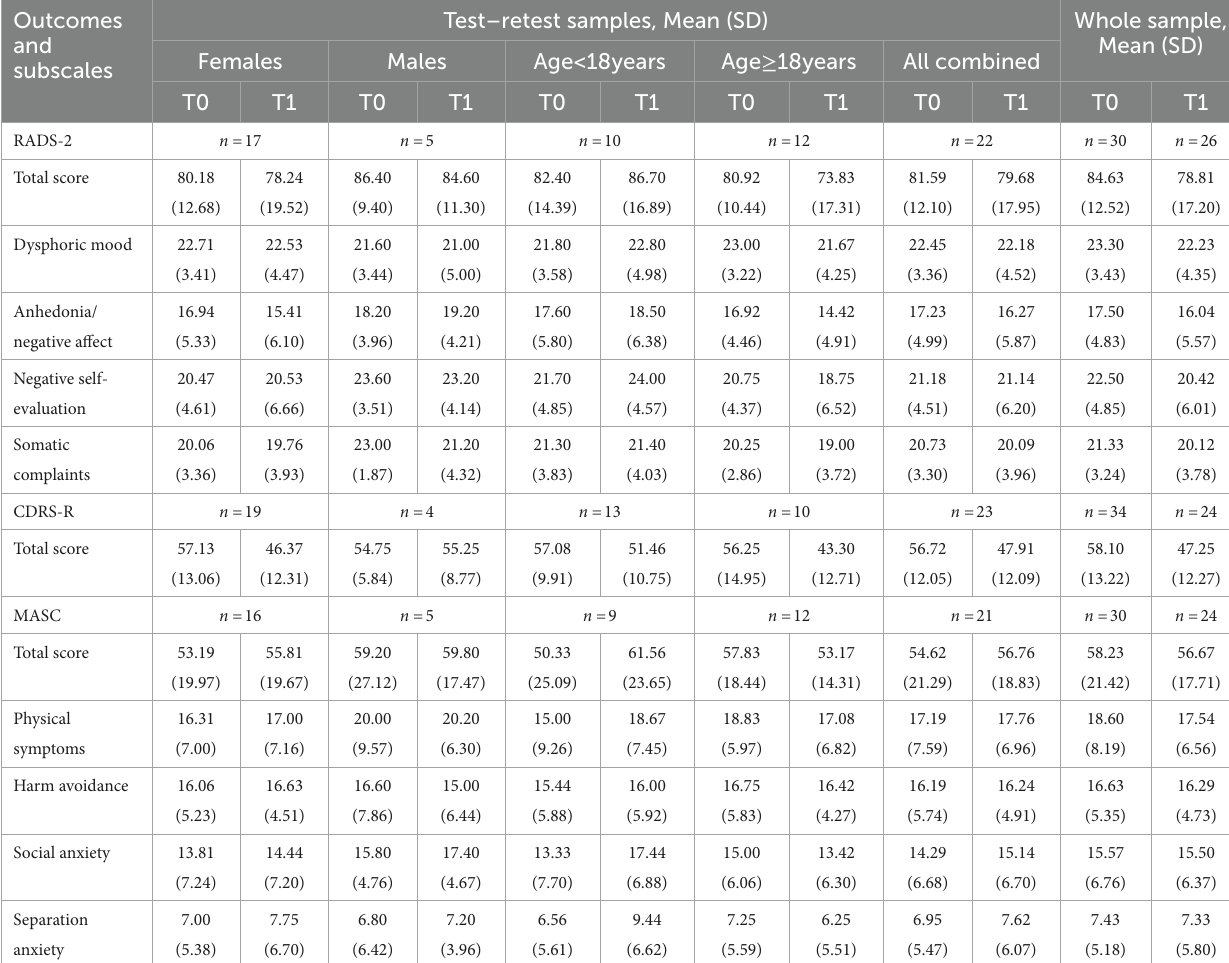
TABLE 4 Descriptive pre-post data on primary and secondary outcome measures including subscales, in test–retest samples presented by sex and age categories, with subgroups combined, as well as for the whole sample. Outcomes and